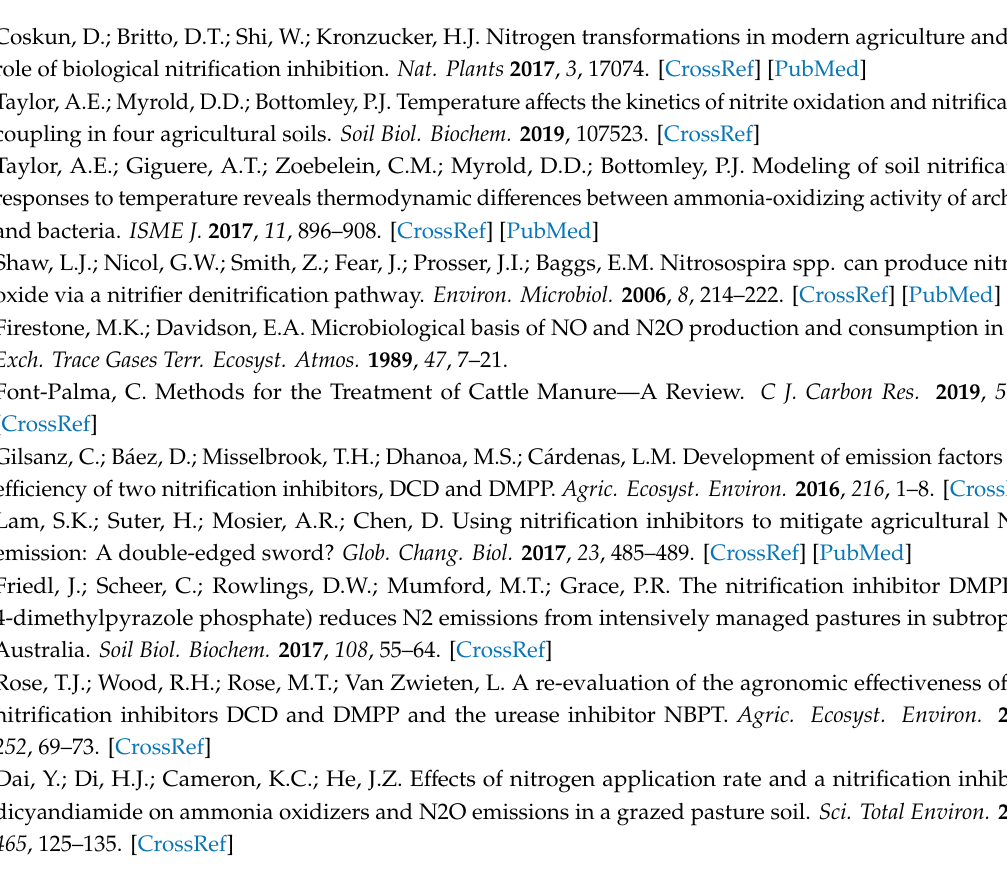
Figure S1: Inhibitory e ff ect of DCD and DMPP at four application rates over a temperature gradient, Table S1: Physicochemical prosperities of cropped and non-cropped soil samples, Table S2: The required amount of DCD and DMPP (mg / kg of dry soil) to achieve the inhibitory e ff ect ≈ 50% for non-cropped and cropped soils, Table S3: Table S4: ANOVA analysis with Tukey’s post hoc test to assess the significant di ff erence in proportional inhibitory e ff ect (PIE) among measured temperatures for non-cropped soils, Table S5: ANOVA analysis with Tukey’s post hoc test to assess the significant di ff erence in proportional inhibitory e ff ect (PIE) among measured temperatures for cropped